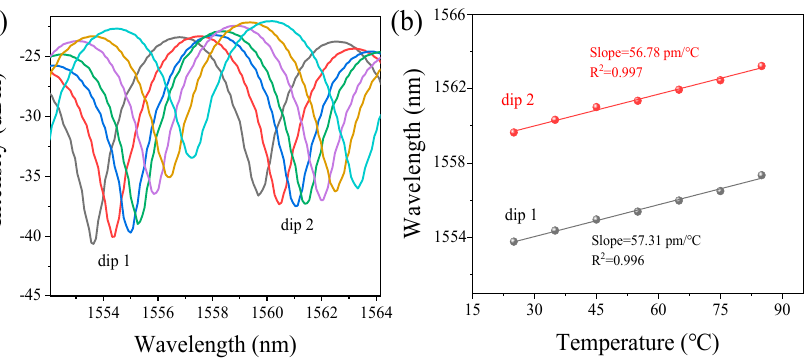
Figure 10. ( a ) Transmission spectra of t -TCF with varied temperature and ( b ) the relationship between wavelength response and temperature.